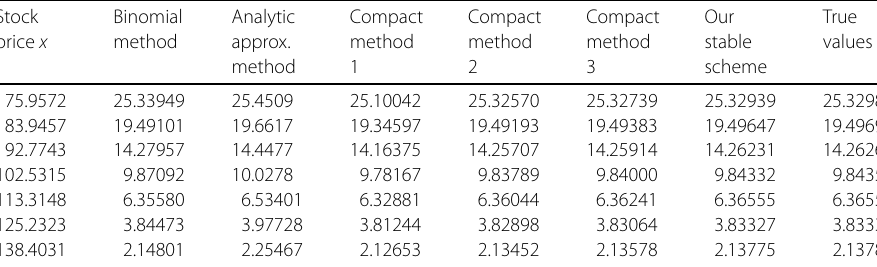
Table 4 Comparison of the American put option values at different underlying values with parameters: σ = 0.3, t = 0, T = 1, r = 0.04, d = 0.02, E = 100, X =